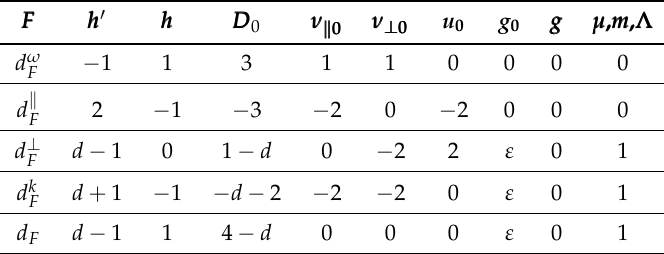
Table 1. Canonical dimensions of the fields and the parameters in the theory (4); ε = 4 − d